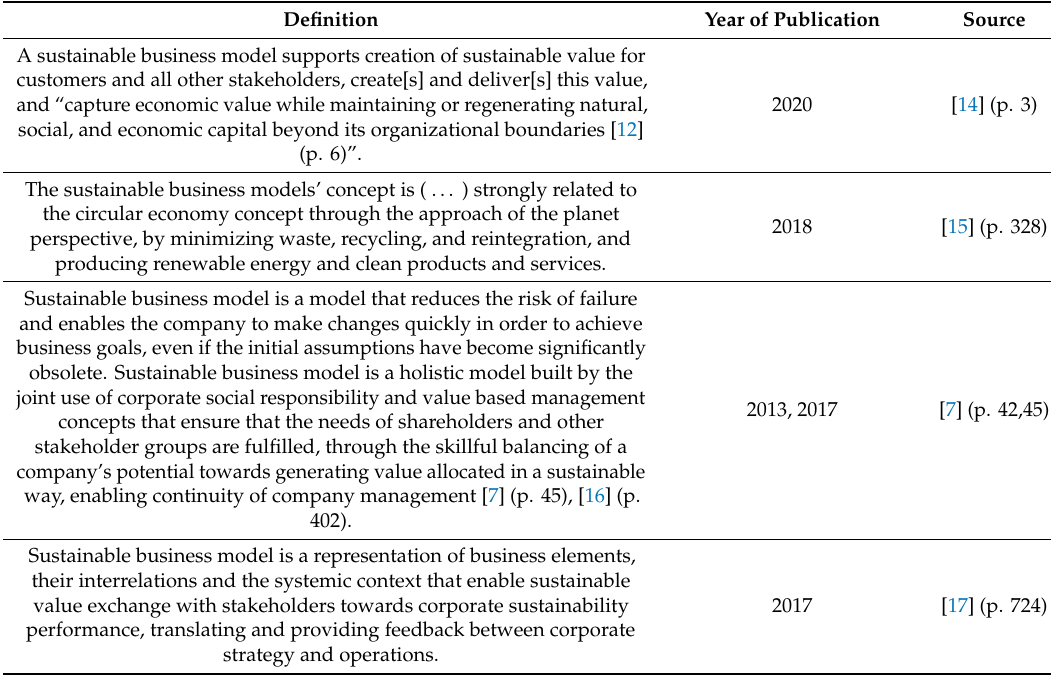
Table 1. Selected definitions of sustainable business